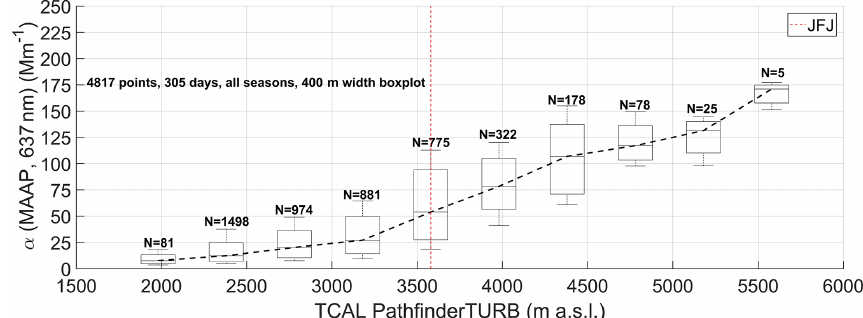
Figure 8. Box plot showing the relation between the absorption coefficient at 637nm measured by the MAAP at the JFJ versus the TCAL retrieved by PathfinderTURB for the period September 2014 to November 2015. The boxes show the median (within the box), the interquartile range (upper and lower box boundaries) and the 15.87–84.13 percentile range of α values (whiskers).